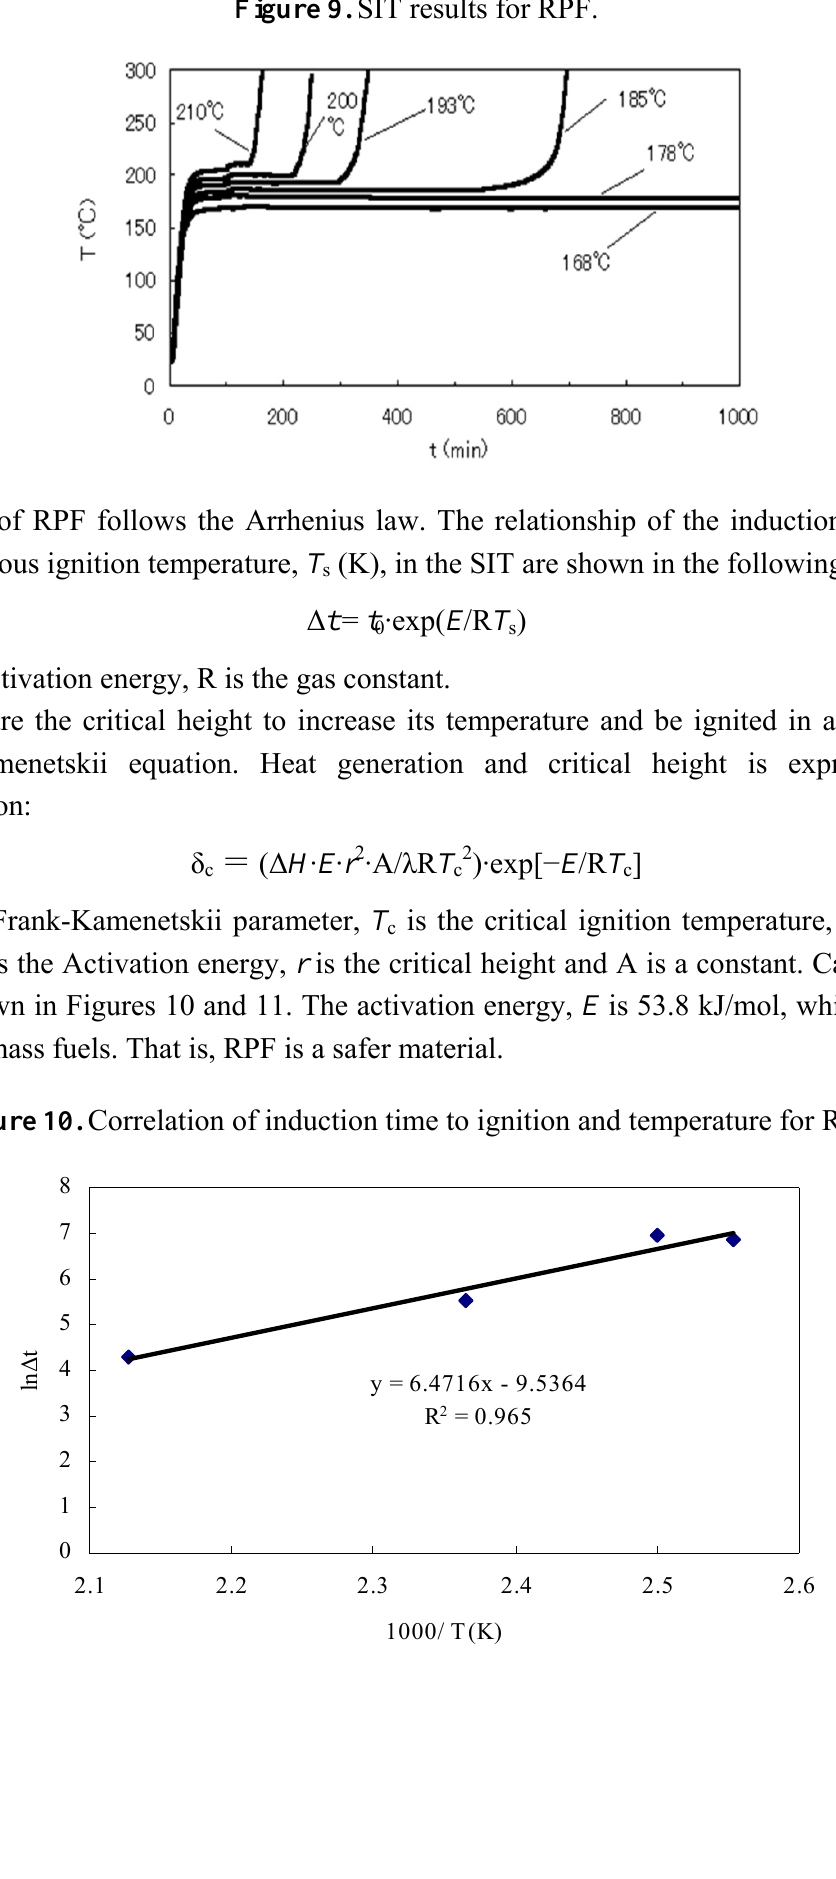
Figure 9. SIT results for RPF.